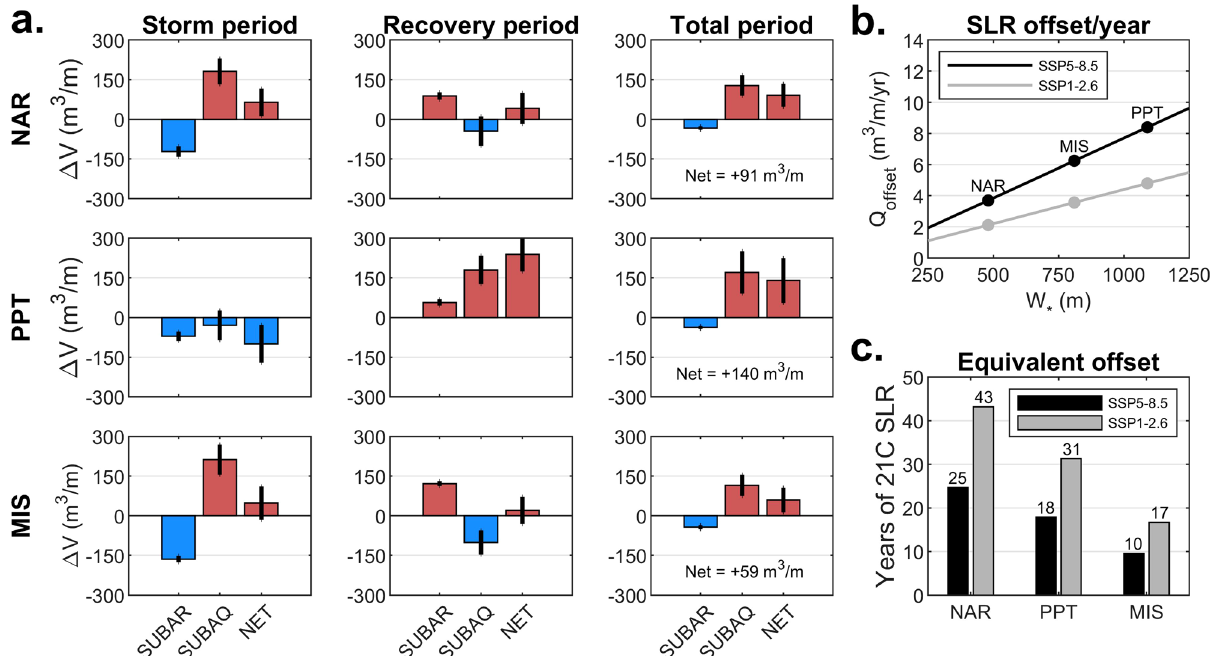
Fig. 6 Overall sediment budget changes due to extreme storm-recovery sequences can offset up to decades of predicted shoreline retreat due to sea- level rise. a Alongshore-averaged volume change (per unit meter) for Narrabeen (NAR), Perranporth (PPT), and La Misión (MIS) beaches are indicated for the storm and recovery periods, separated into subaerial (SUBAR), subaqueous (SUBAQ) and overall net change (NET). Error bars denote the 95% con fi dence interval for calculated volume changes considering survey error. b The annual rate of sediment input required to theoretically offset predicted SLR recession over the 21st Century using the Bruun rule ( Q offset ) for the three sites under SSP1-2.6 and SSP5-8.5 scenarios; and c the equivalent years of 21st Century SLR that may be theoretically offset due to the net volumetric gains over each total